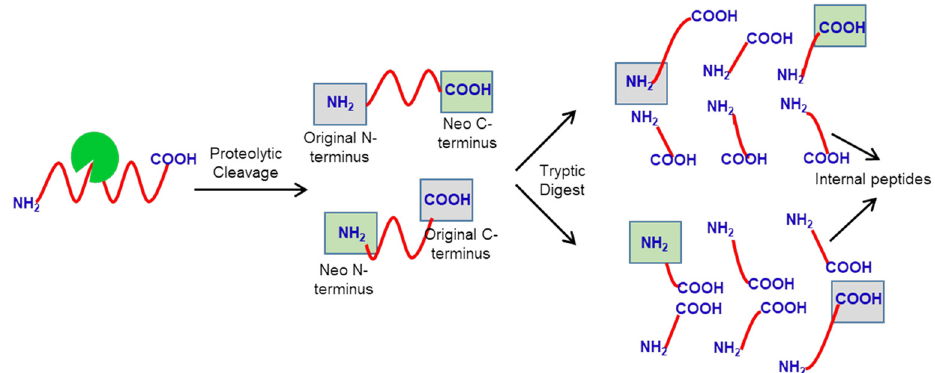
Figure 1. N-terminomics approach. Neo-N-terminal peptides and internal tryptic peptides. The overall workflow of the N-terminomics includes the separation of neo-N-terminal peptides from the terminal tryptic peptides.